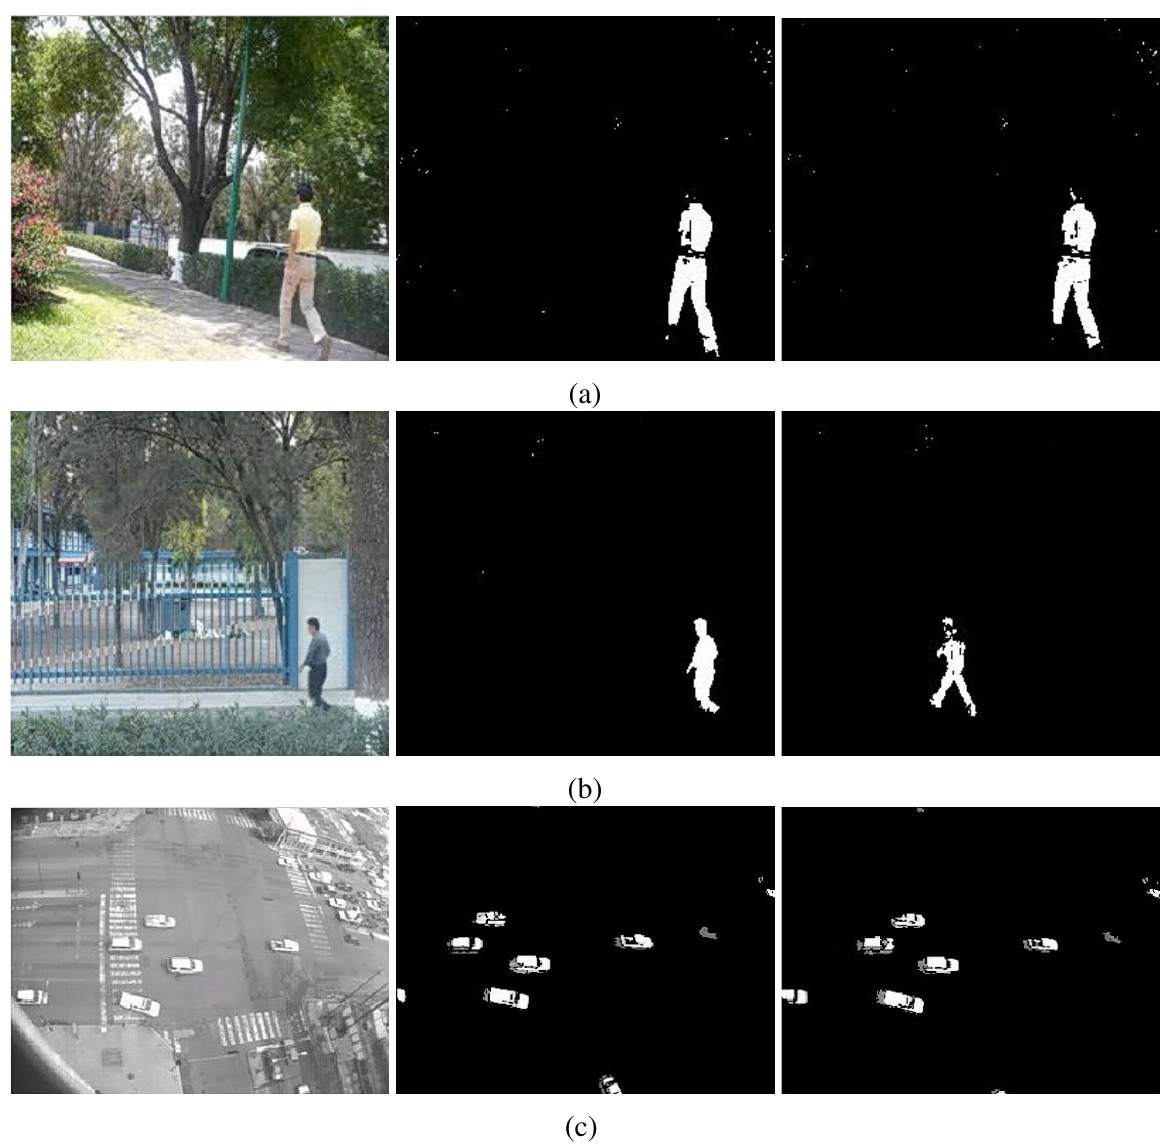
Figure 8. Foreground detection from (a) a camera monitoring a public garden, (b) a camera monitoring a people lane, (c) a camera monitoring an intersection. The first two images show several leafs moving caused by wind and the scene is continuously changing. The third one, shows cloud shadows causing changes of luminance